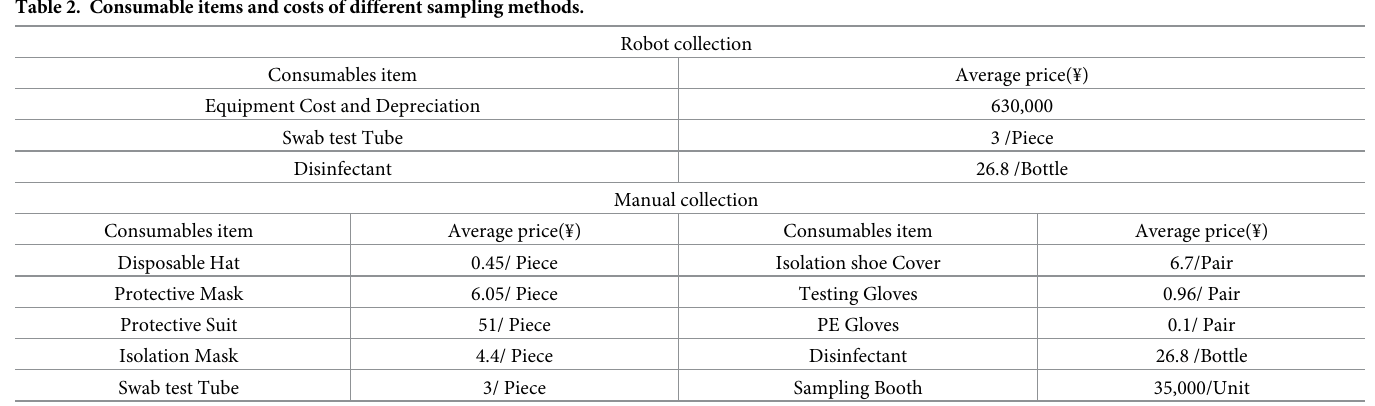
Table 2. Consumable items and costs of different sampling methods.